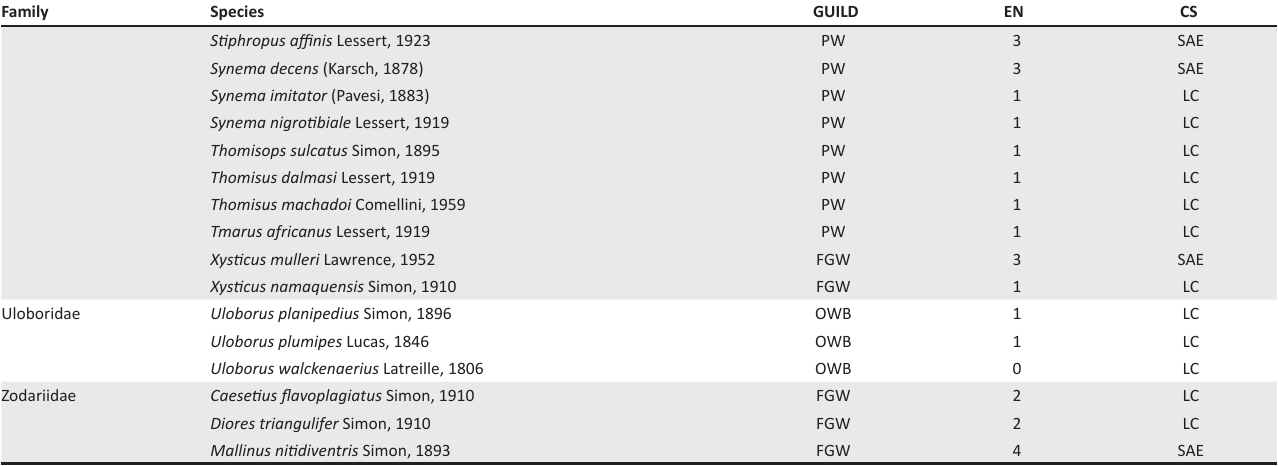
TABLE 1-A1 (Continues...): Checklist of the spiders of Tswalu Kalahari Reserve with guild, endemicity (EN) and conservation status (CS). Family